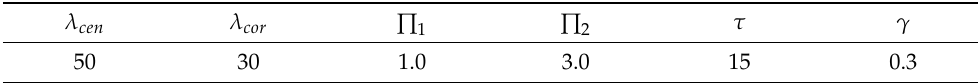
Table 1. Parameter settings of SGM-MSIF.